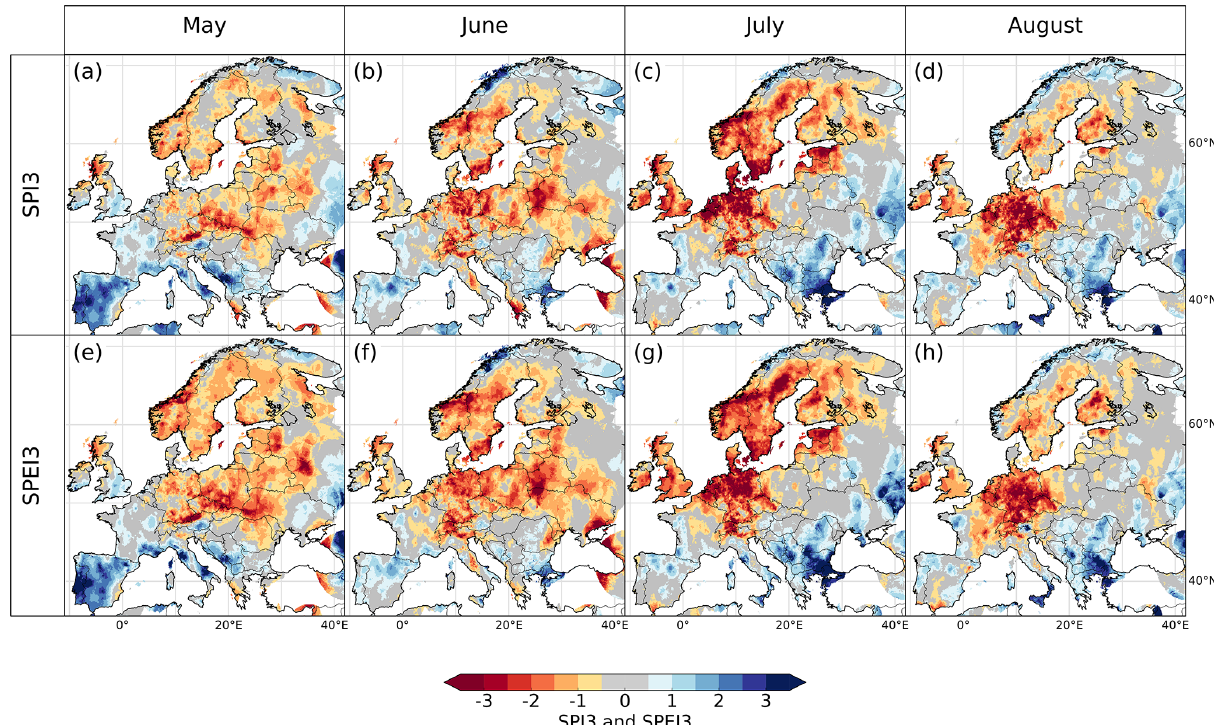
Figure 6. Meteorological drought 2018 indexed by SPI3 for (a) May, (b) June, (c) July, and (d) August, and SPEI3 for (e) May, (f) June, (g) July, and (h) August. Reference period used is